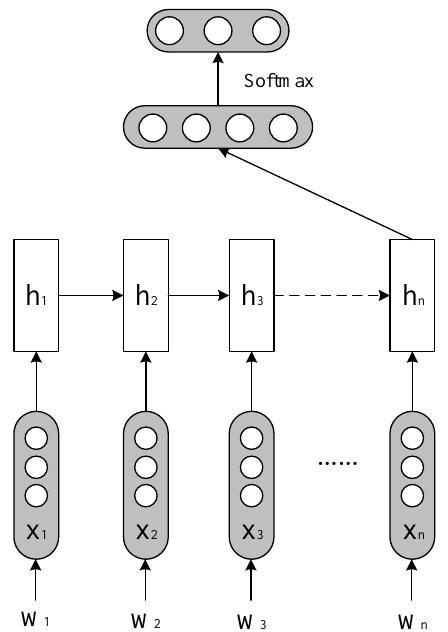
Figure 3. Hashtag recommendation with standard LSTM